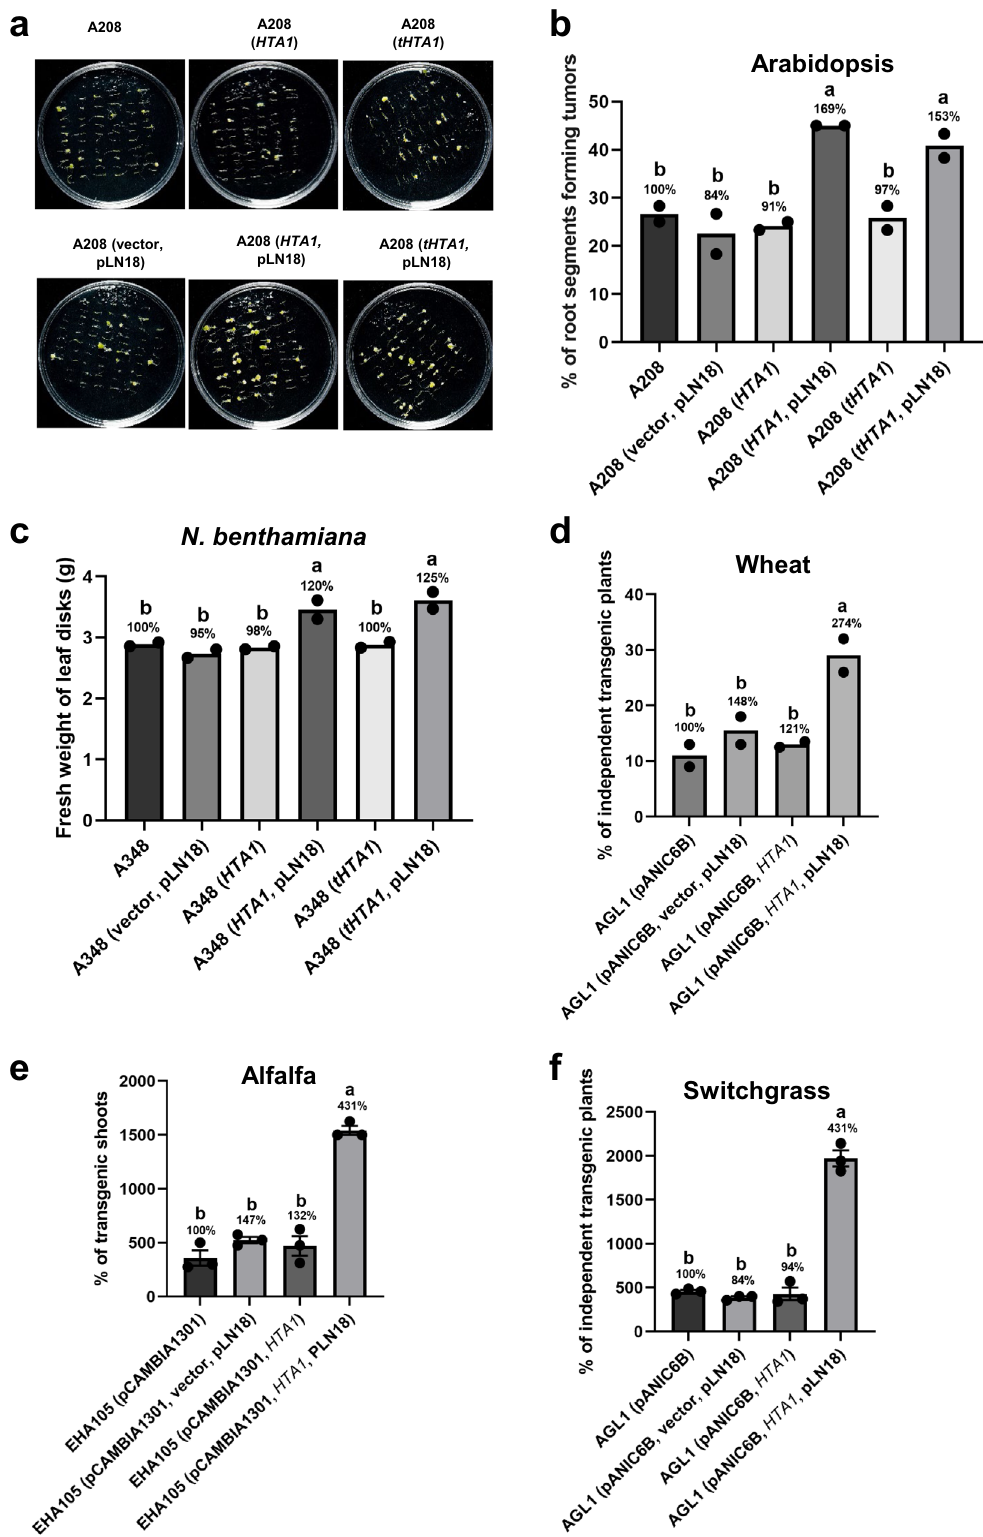
strain expressing T3SS and AvrPto did not show major differ- ences from control strains. Agrobacterium infection induces the expression of various plant defense genes, including PR genes and those encoding chitinases and defensins 7,32,60 . FRK1 , a commonly used molecular marker gene to study T3E-mediated suppression